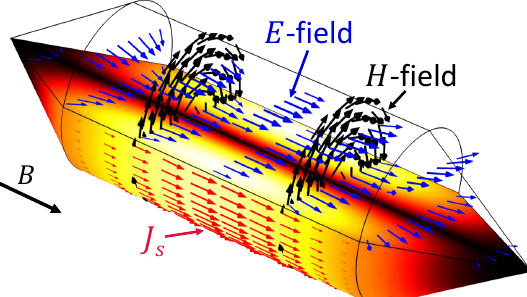
Figure 1. Electromagnetic simulation of the haloscope excited with the TM 010 mode. The distributions of the radio frequency electric E -field (in blue), the magnetic H -field (in black), and the surface current density J s (in red) are shown. The direction of the externally applied static B field is shown to be parallel to the longitudinal axis of the cavity.